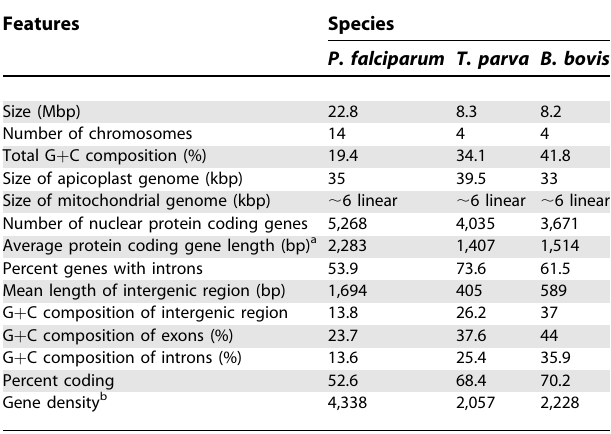
Table 1. Genome Characteristics of B. bovis , T. parva , and P.